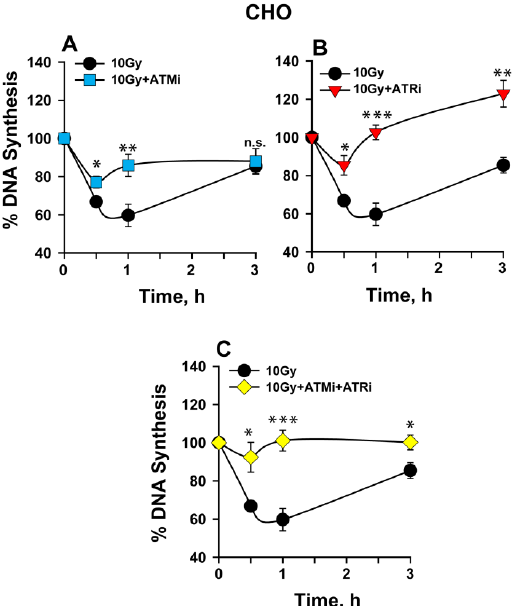
Figure 1. IR-induced intra-S-phase checkpoint in CHO cells. ( A ) Percentage of DNA synthesis over unirradiated controls measured after exposure to 10 Gy in the presence or absence of ATMi. ( B ) As in ( A ) for cells treated with ATRi. ( C ) As in ( A ) for cells treated with a combination of ATMi and ATRi. Error bars represent the standard deviation from 3 independent experiments. The significance of differences between individual measurements is indicated by * symbol: * p < 0.05, ** p < 0.01, *** p < 0.001; n.s. non-significant.